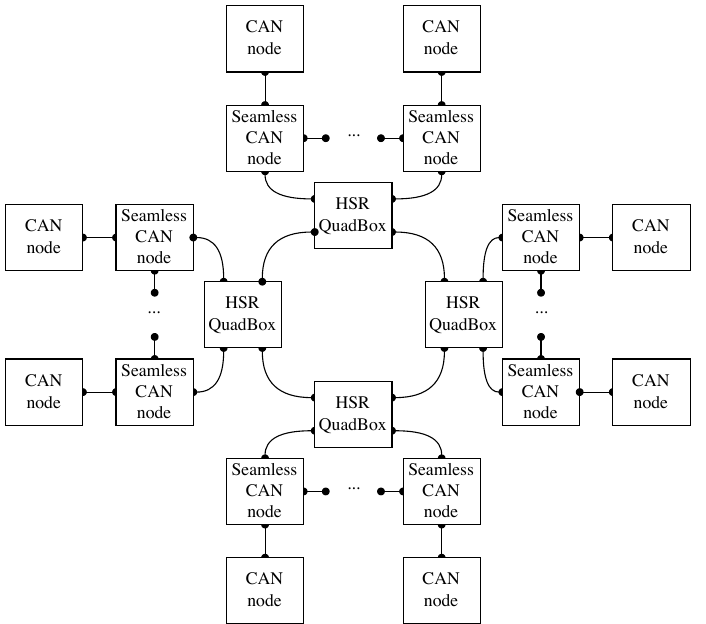
Figure 5. Example of a seamless CAN-based network architecture with four domain functions in a